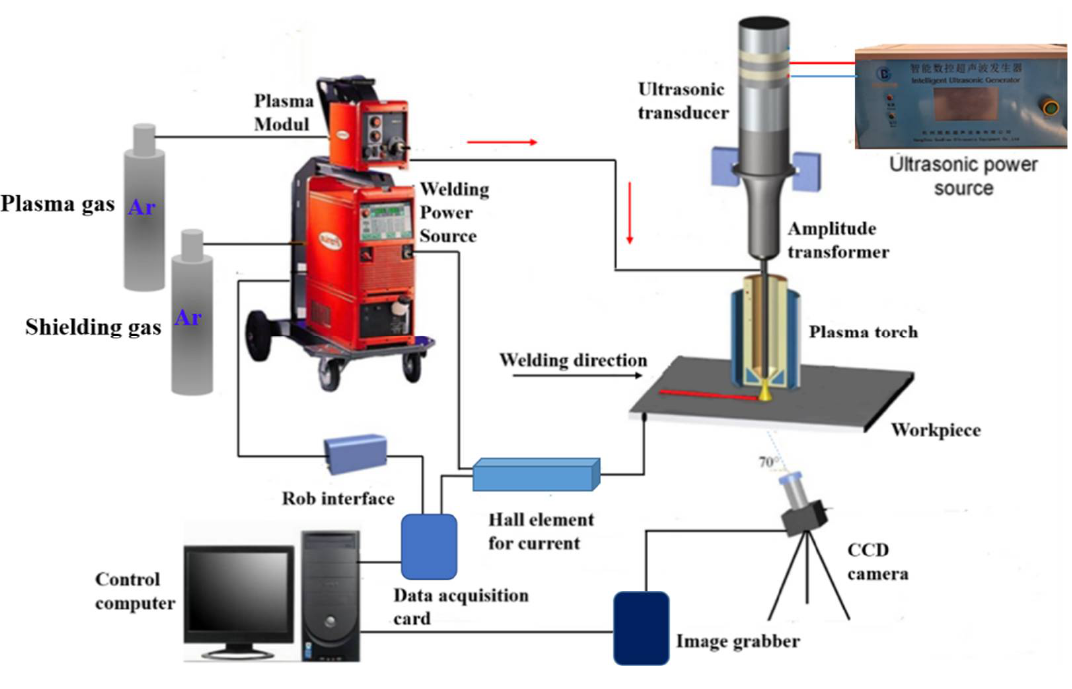
Figure 5. Schematic illustration of the ultrasonic-assisted plasma arc welding (U-PAW) process setup.